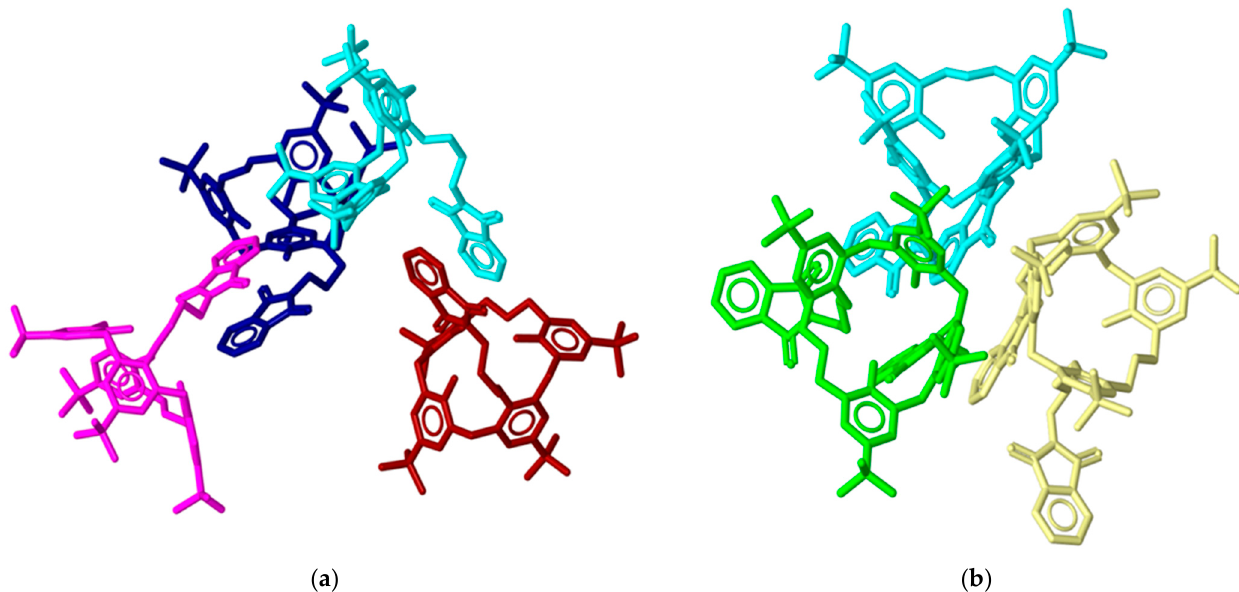
Figure 7. Illustration of intermolecular π -stacking interactions observed in the crystal packing of 2a ( a ) and 3a ( b ). In 2a , the molecules are present as dimeric species through π -stacking of the phthalimide groups of the 4 independent molecules (violet-blue and cyan-brown). In 3a , in addition to an intramolecular π -stacking interaction observed in one of the independent molecules (cyan), there is an intermolecular π -stacking interaction between the other two (green-yellow). For clarity, independent molecules are represented in arbitrarily chosen different colors, while hydrogen atoms, atom disorder and solvent molecules are omitted.